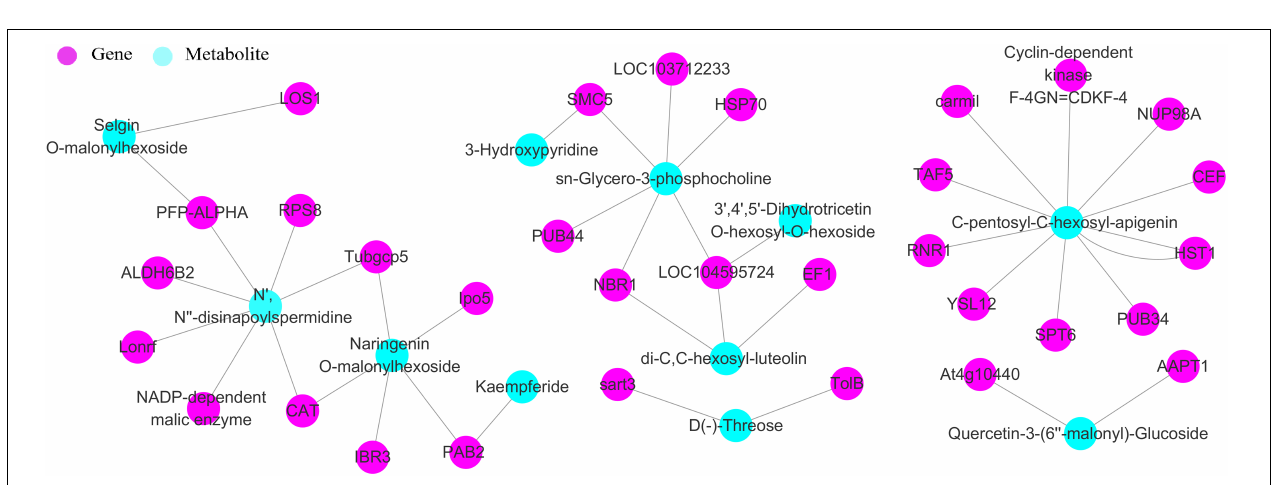
metabolism pathway (ko0564), arginine and proline metabolism pathway (ko0330), purine metabolism pathway (ko0230), tryptophan metabolism pathway (ko0380), and phenylpropanoid biosynthesis pathway